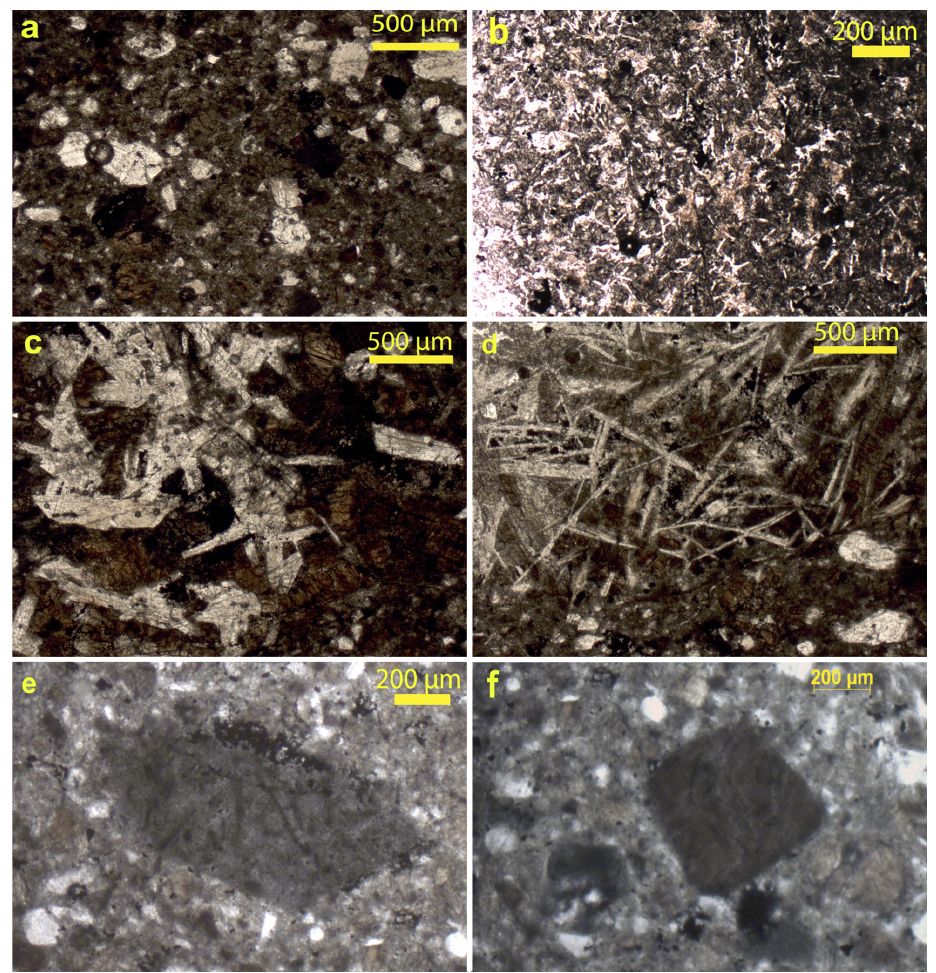
Figure 3 - Transmitted plane polarized light photomicrographs of Serra Pelada showing variability of clast type: ( a ) MM – clastic fine to medium grained matrix , b ) FX – very fine grained clast , c ) CX - coarse grained clasts, d ) MX - Medium grained clasts, e - f ) RX - recrystallized impact